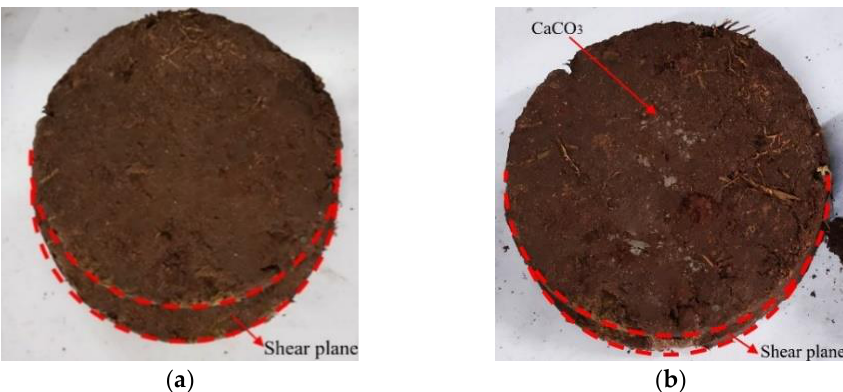
Figure 7. Shear plane of samples under different cementation concentrations. ( a ) 0.00 M sample; ( b ) 1.00 M sample.